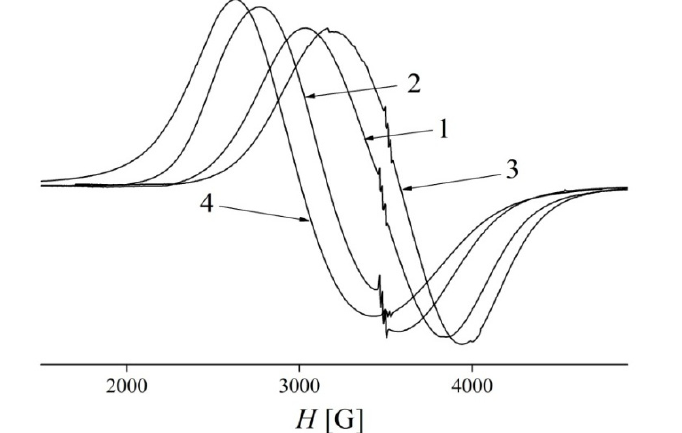
Figure 2. Ferromagnetic resonance (FMR) spectra of magnetite nanoparticles in polyacrylamide gel (1, 2, 3) and in water (4). 1—gel synthesized without magnetic field; 2—gel synthesized in a magnetic field of ~1.5 kG and orientated by its magnetic axis along the spectrometer field; 3—gel synthesized in a magnetic field of ~1.5 kG and orientated by its magnetic axis across the spectrometer